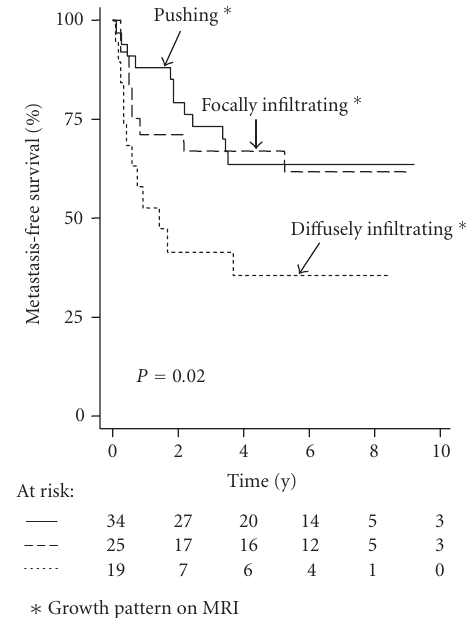
Figure 2: Kaplan-Meier survival curves in relation to infiltrative growth identified on MRI ( P = .